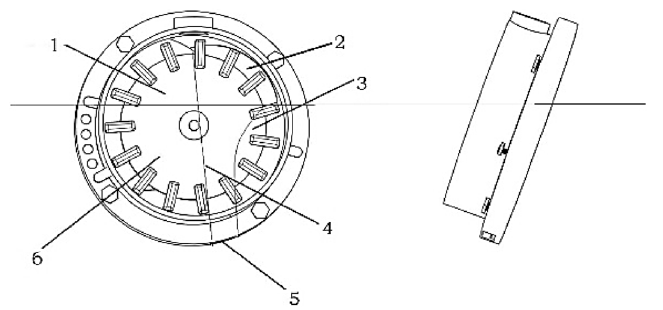
Figure 3. Working zone of the inclined seed-metering